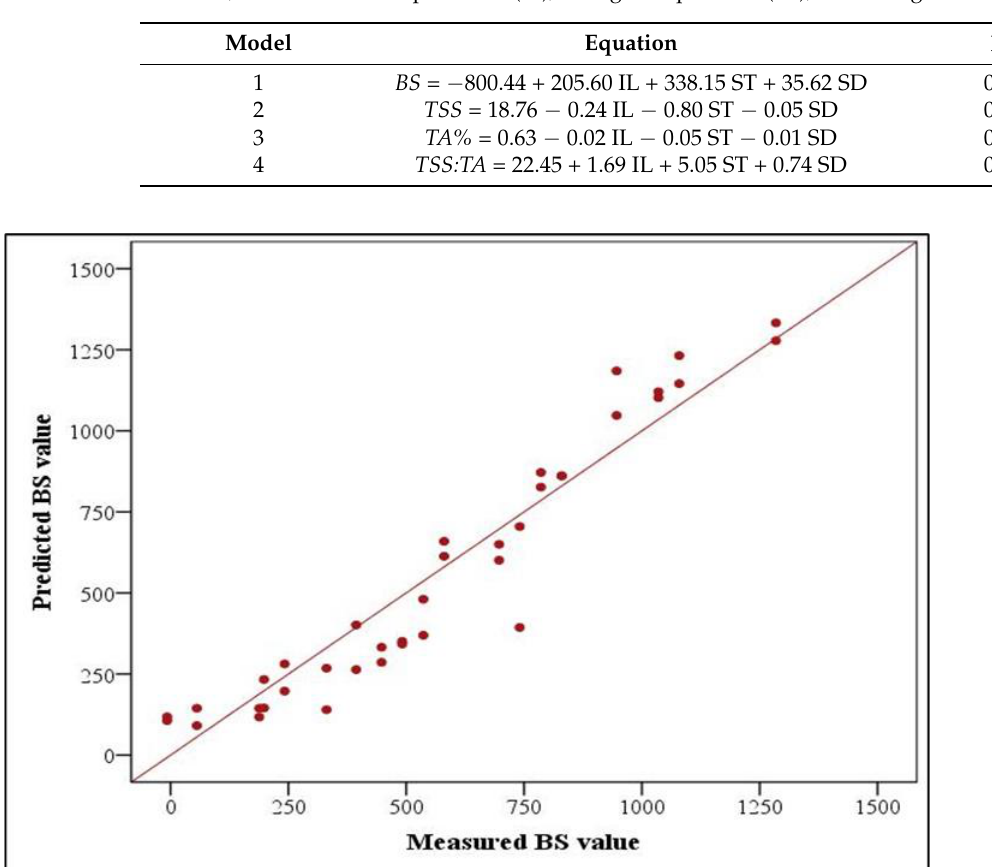
Figure 5. Results for the prediction of bruise susceptibility ( BS ) values based on the linear regression model. Predicted BS versus measured BS (Model 1). Table 4. Linear regression equations of dependent variables (bruise susceptibility ( BS ), total soluble solids ( TSS ), titratable acidity ( TA% ), and sugar:acid ratio ( TSS:TA )) in relation to the independent variables, which include impact level (IL), storage temperature (ST), and storage duration (SD).